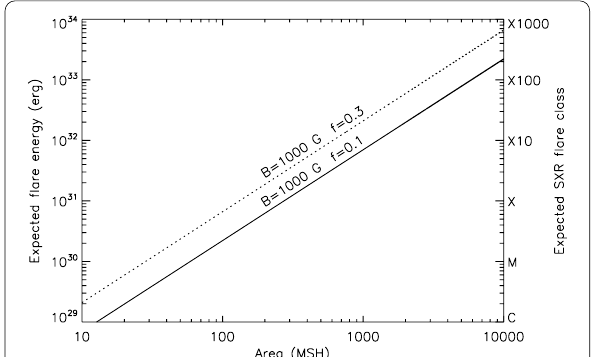
Fig. 3 Relationship between sunspot area and expected flare energy or SXR flare class calculated from the sunspot